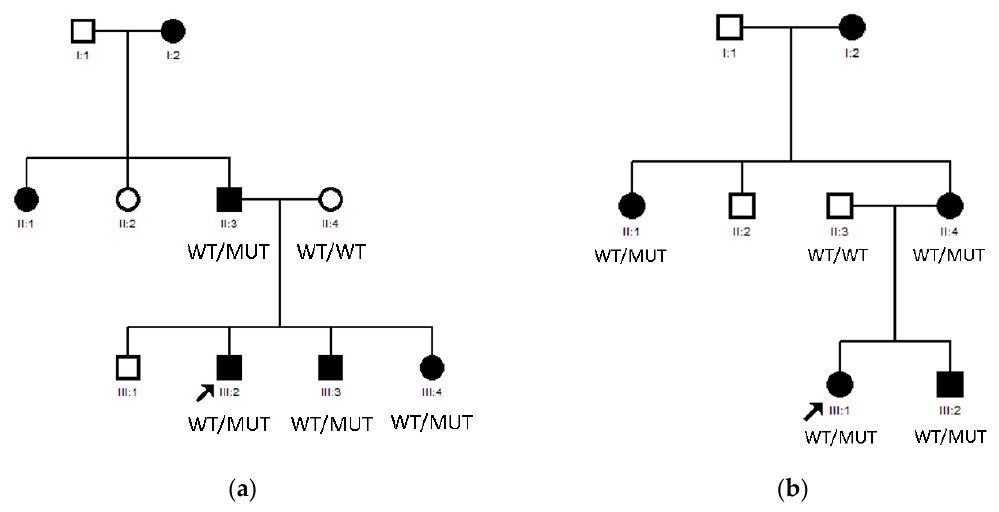
Figure 2. ( a ) Pedigree of Family 17; ( b ) Pedigree of Family 18.